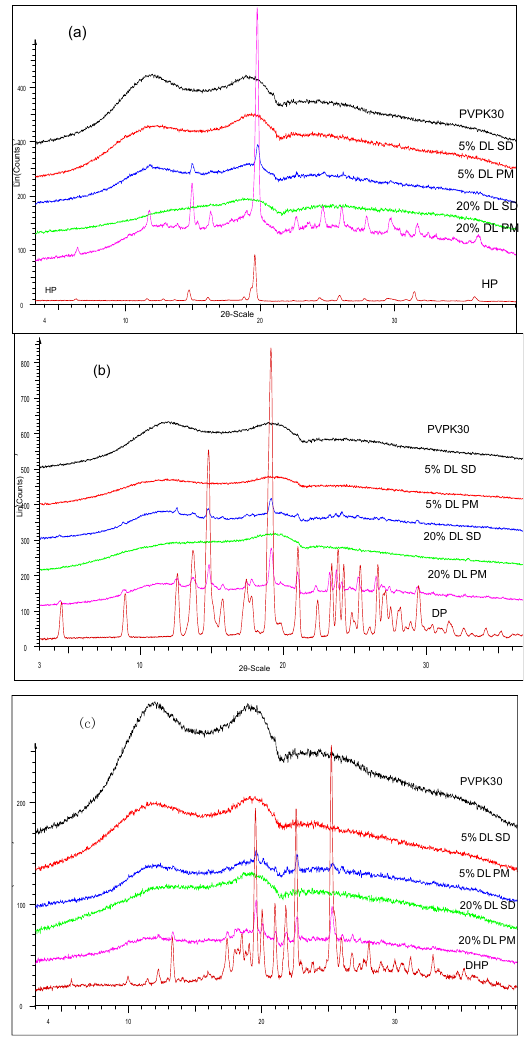
Figure 2. XRPD of ( a ) HP; ( b ) DP; ( c ) DHP with PVPK30 solid dispersion (SD) and physical mixture (PM). The drugs found amorphous in solid dispersion and crystalline in physical mixture.